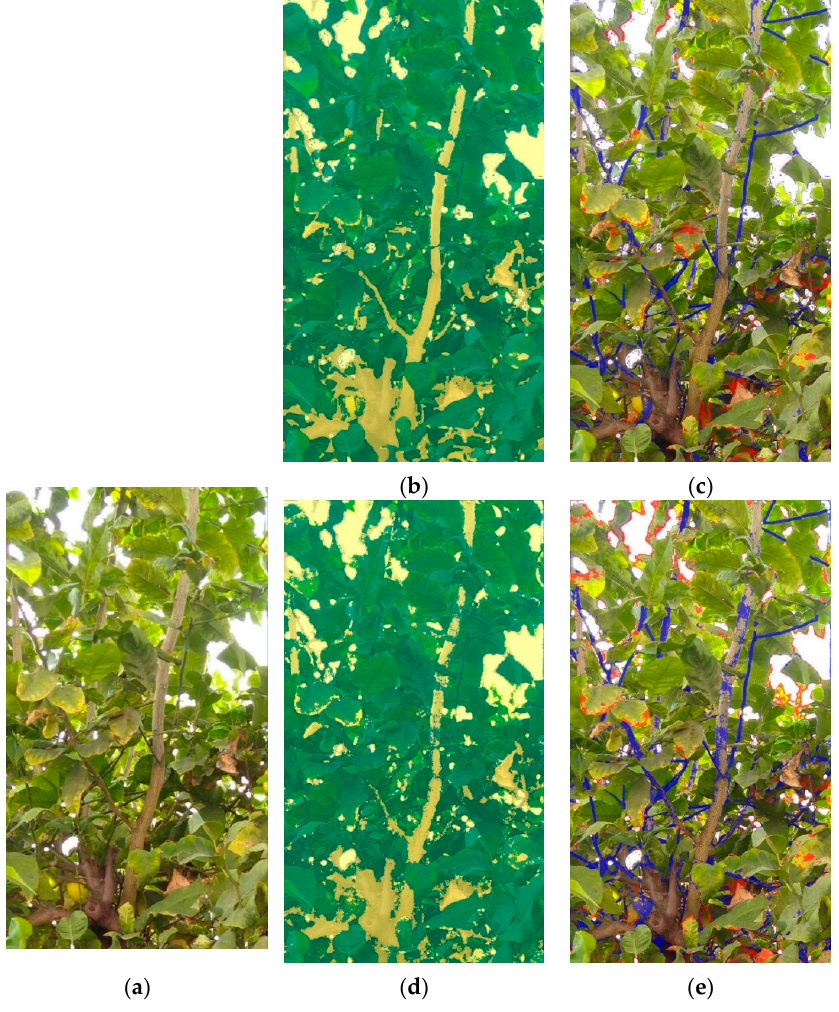
Figure 7. Test picture segmentation example: ( a ) original image, ( b ) SVM segmentation, ( c ) SVM errors, ( d ) deep-learning segmentation, ( e ) deep-learning errors.